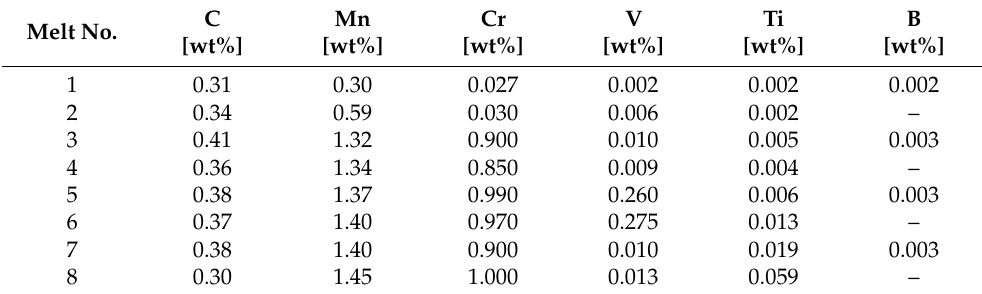
Table 1. Chemical composition of the analyzed melts. Melt No.